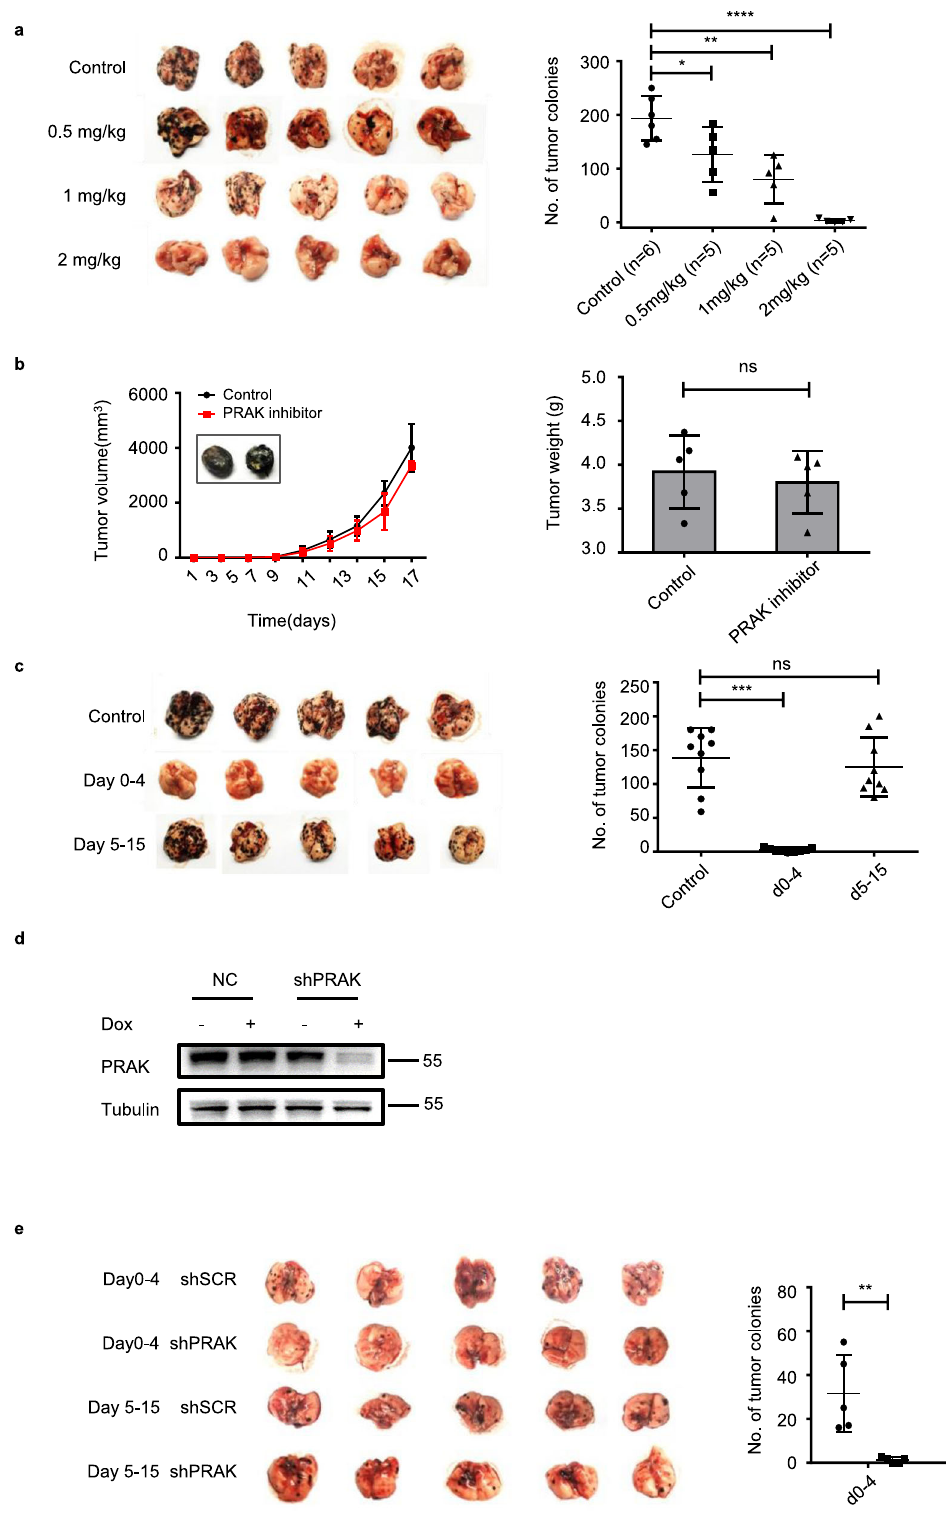
GLPG0259 (Fig. 2b). Notably, the PRAK inhibitor displayed a critical time window of action. While its delivery on the fi rst fi ve days after tumor cell injection gave rise to similar results to full course treatment, inhibition was hardly detected if the drug was administrated after day 5 (Fig. 2c). To further test the time window at the genetic level, a B16 subclone expressing